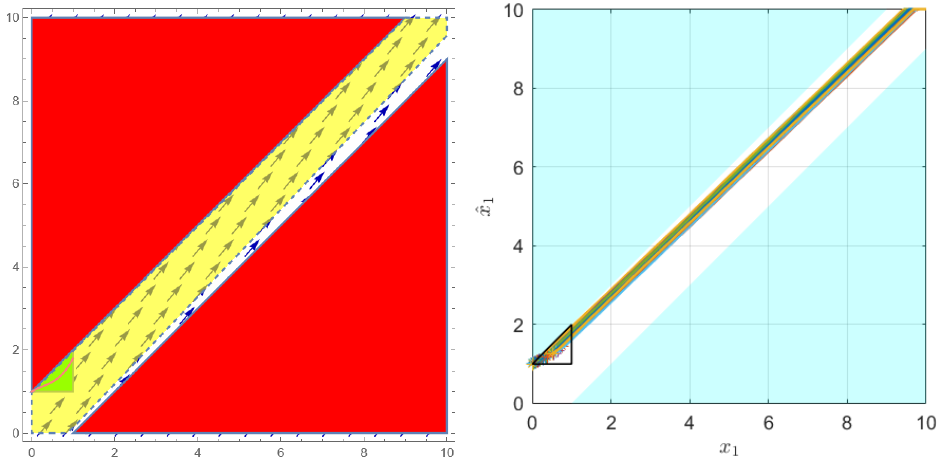
Figure 3. ( Left ) Phase portrait of Example 1 with x 2 = ˆ x 2 = 0. The pink line and the green, red, and yellow regions are the initial sets (cid:101) Θ 0 and Θ 0 , the unsafe set Θ u and the sub-level set of B ( x , ˆ x ) , respectively. ( Right ) State runs of Π × Π on the projection of the position plane starting from (cid:101) Θ 0 . The blue region represents the unsafe set Θ u